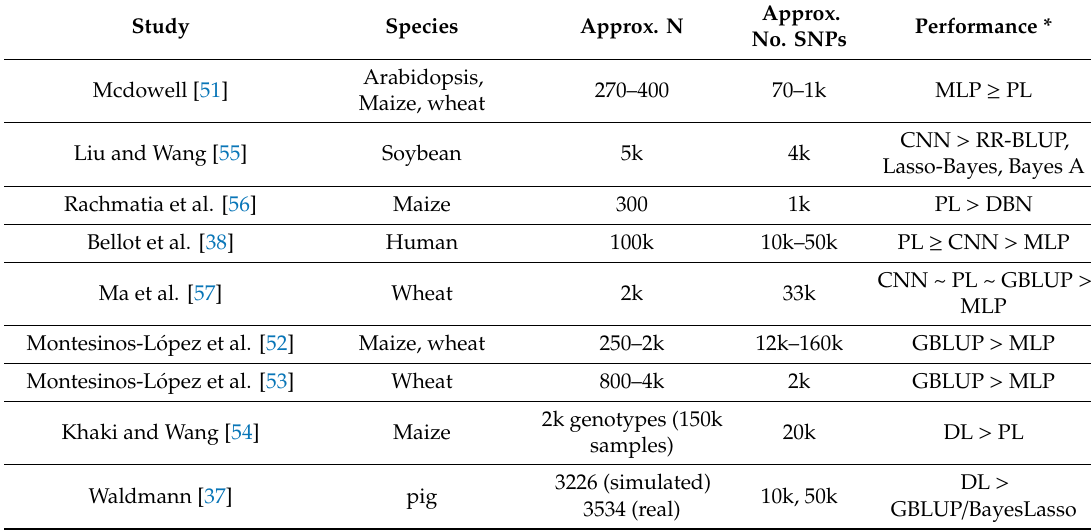
Table 2. Applications of deep learning to genomic